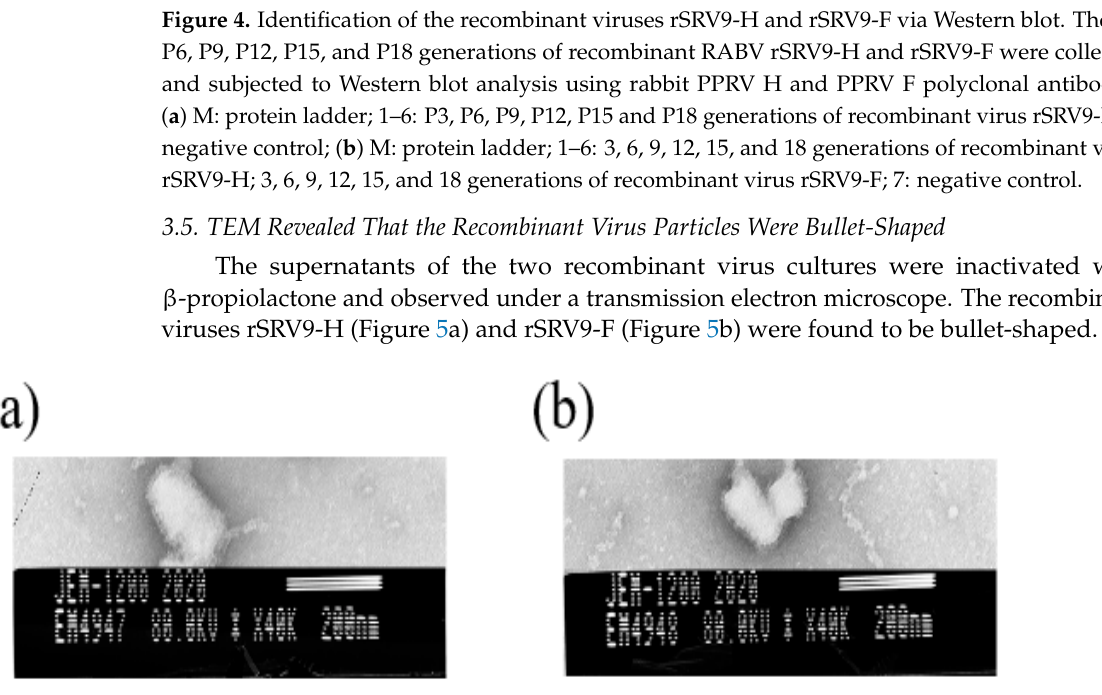
Figure 6. Growth kinetics assay of recombinant viruses rSRV9-H and rSRV9-F. At 0, 24, 48, 72, and 96 h after infection with recombinant viruses, 200 μ L of the supernatant was collected, and virus titers were determined by TCID 50 at 5 timepoints. 3.7. Stable Inheritance of Exogenous Gene Expression in Recombinant Viruses The RNA genomes of the P3, P6, P9, P12, and P15 generations of recombinant viruses were extracted for RT–PCR; the results are shown in Figure 7. The corresponding antigen genes were detected in the genomes of the recombinant viruses of each generation, and the PCR products were verified by sequencing. The results showed that the inserted gene was stably inherited and correctly expressed in the recombinant RABV.